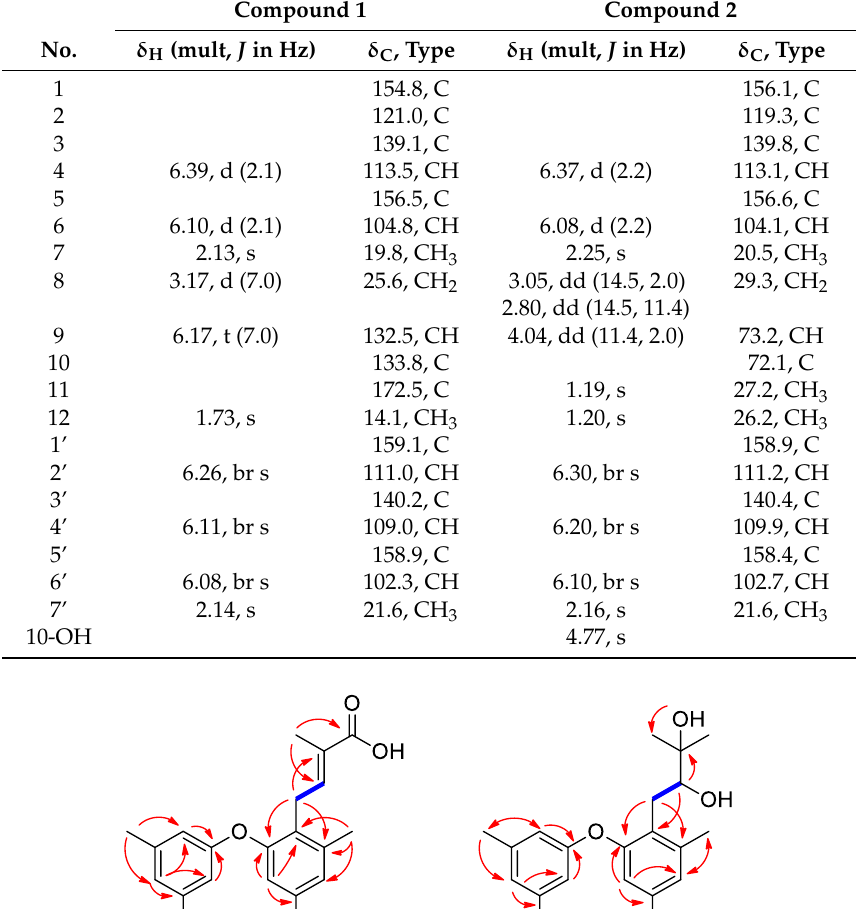
Table 1. 1 H (500 MHz) and 13 C-NMR (125 MHz) data of compounds 1 and 2 in DMSO- d 6 .